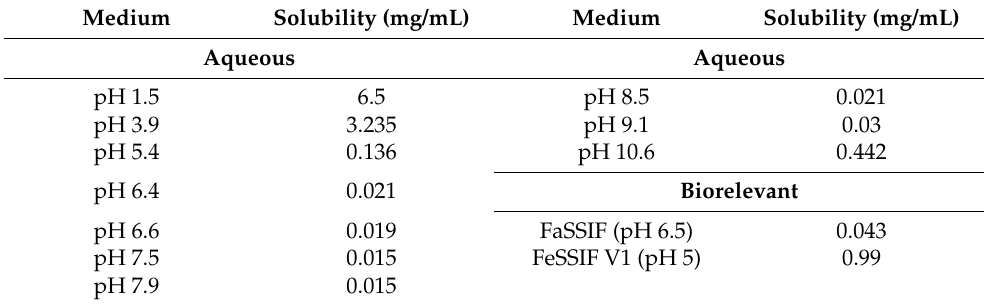
Table 1. Aqueous and Biorelevant solubility of the model drug [8]. For modelling purposes, it has been assumed that the quoted pH values are those at the end of the equilibration period and not the nominal pH